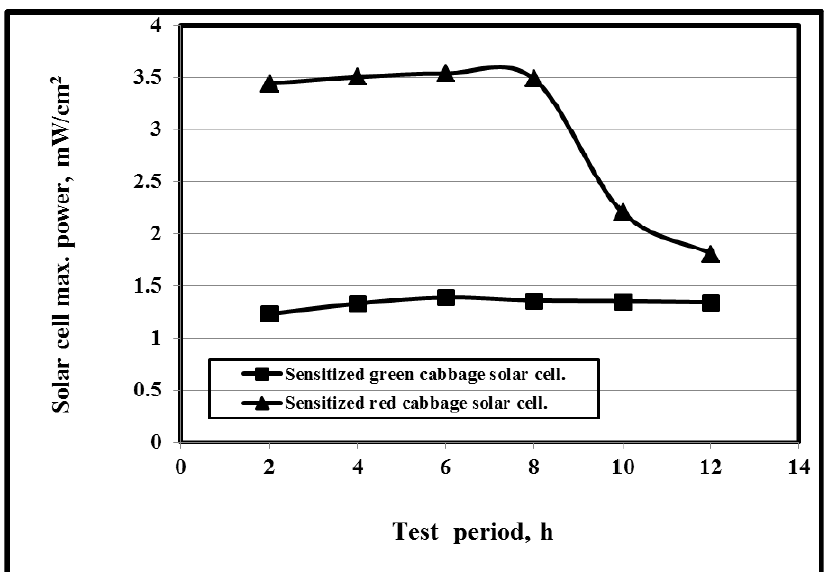
Figure 17. Max. power/test period relation for RC and GC.